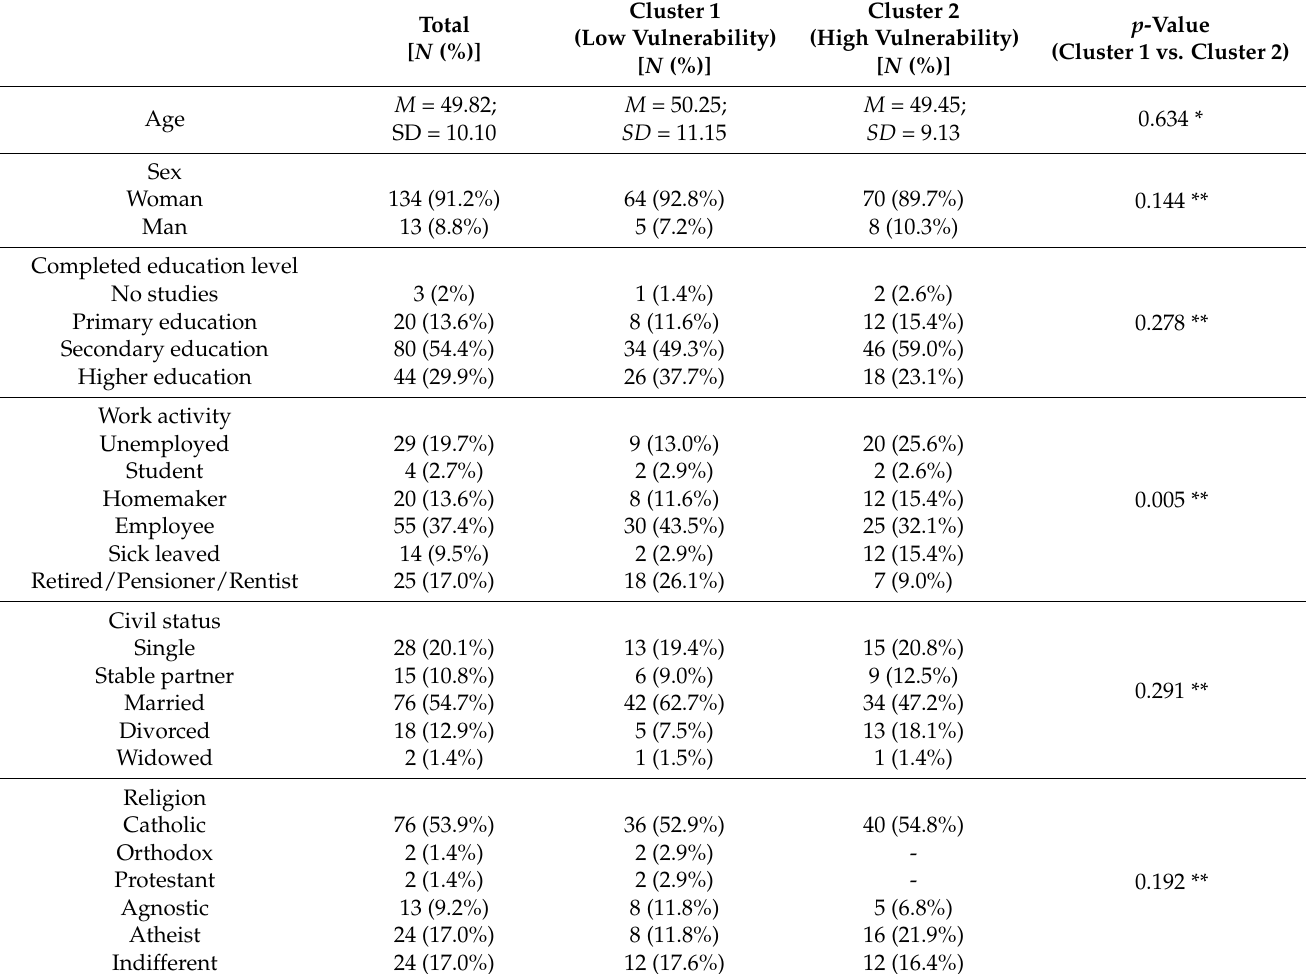
Table 1. Socio-demographic characteristics of the